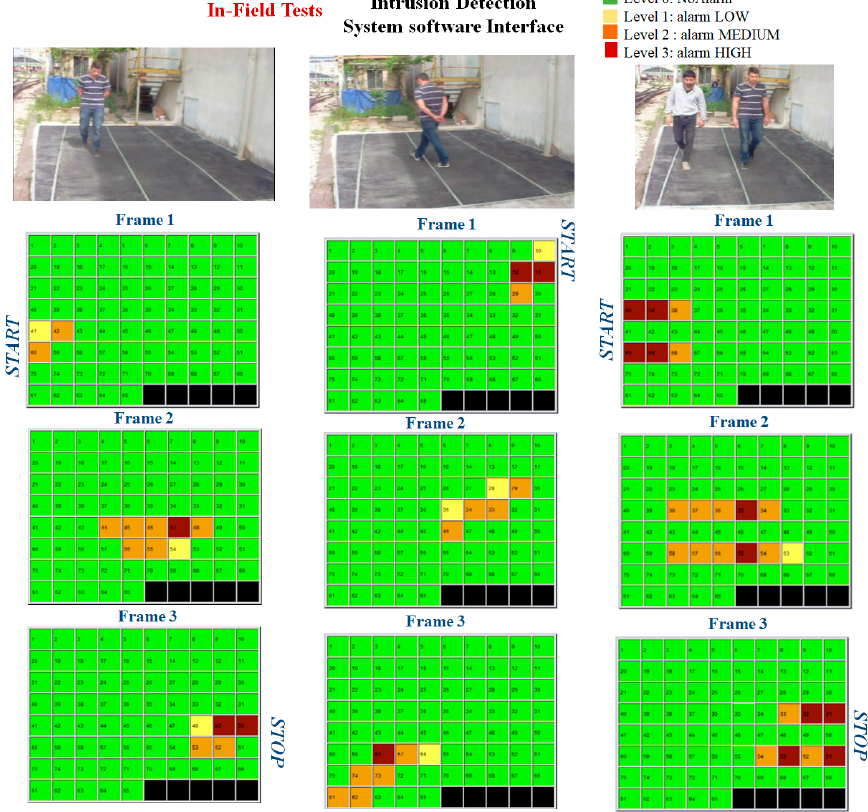
Figure 22. In-field test of the intrusion detection system. Reproduced with permission from ref. [161] (the figure is released under a Copyright Clearance Center’s RightsLink ® service).